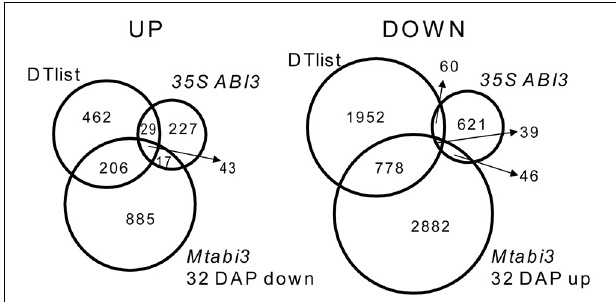
FIGURE 5 | Venn diagram identifying DT transcripts related to ABSCISIC ACID 3 (ABI3 ) of Medicago truncatula . Transcripts that were identified in the DT-UP or DT-DOWN lists were compared to those that are differentially expressed in Mtabi3 seeds at 32 DAP compared to wild type seeds ( Mtabi3 32 DAP) and to those that are differentially expressed upon ectopic expression of MtABI3 in hairy roots compared to control. Transcript levels were considered significant when P < 0 . 01 and − 1 > Mlog2 >